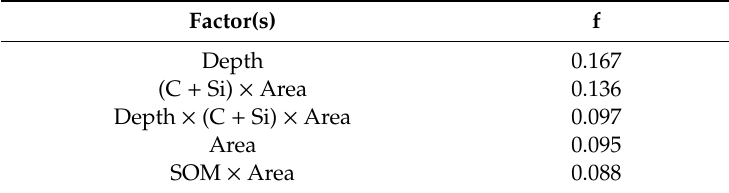
Table 21. Sorted e ff ect sizes (f) of all significant ( p < 0.05) factors a ff ecting penetration